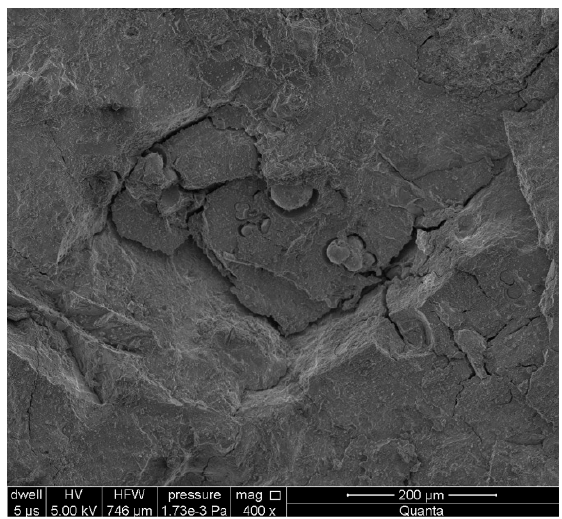
Figure 7. The cracked aggregate (in the central part of the figure) in the cement matrix.